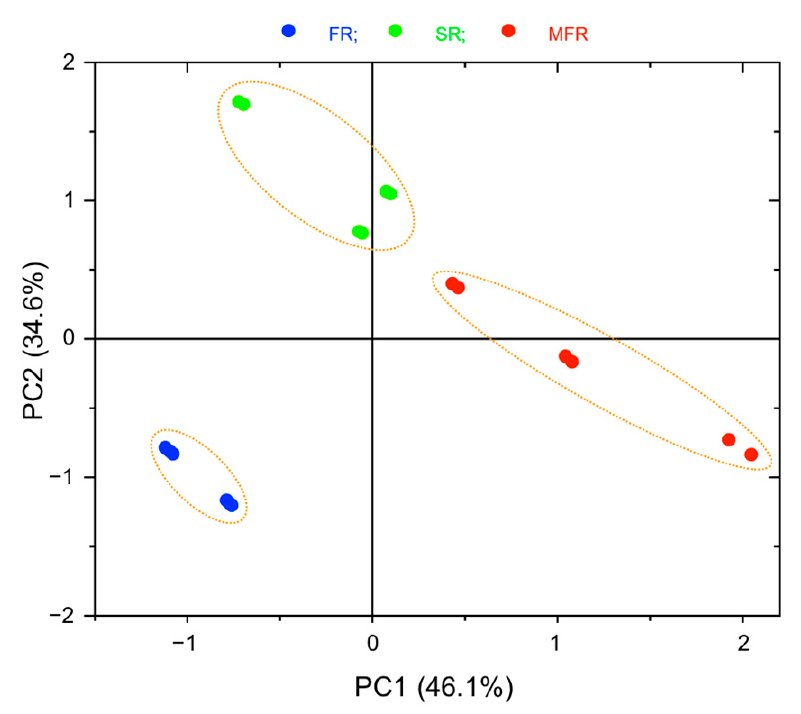
Figure 4. The scatter score plot based on principal component analysis of the FTIR spectra of the root samples. Each of the roots ( n = 3; each pellet was measured two times) was collected from the seed surrounded by S. mycoparasitica against F. graminearum (MFR, red dot); the seed infected by F. graminearum (FR, blue dot); the non-treated or non-infected seed (SR, green dot). The loadings plot of PC1 and PC2 are shown in Figure 5. In the region between 4000– 3200 cm − 1 , the negative influence of PC1 loadings had one peak at 3445 cm − 1 , whereas the positive influence of PC1 had no peak. For PC2 loadings, the positive influence and negative influence were observed at 3403 and 3603 cm − 1 , respectively. These peaks may be partly supportive to differentiate roots (samples) due to the variations of possible molecules including carbohydrates, glycoconjugates, and proteins. For the lipid region between 3050–2800 cm − 1 , the three peaks at 2959 cm − 1 (asymmet- ric CH 3 stretching), 2928 cm − 1 (asymmetric CH 2 stretching), and 2855 cm − 1 (symmetric CH 2 stretching) on the positive influence of PC1 loadings are supportive to distinguish MFR from FR. Further, the negative influence of PC2 loadings shown at 2926 cm − 1 (asym- metric CH 2 stretching) and 2854 cm − 1 (symmetric CH 2 stretching) clearly differentiated FR from SR. Therefore, the increase in the lipid region of FR and MFR may imply that biotic factors such as F. graminearum and S. mycoparasitica (more prominent) contribute to the content of lipids on roots directly or